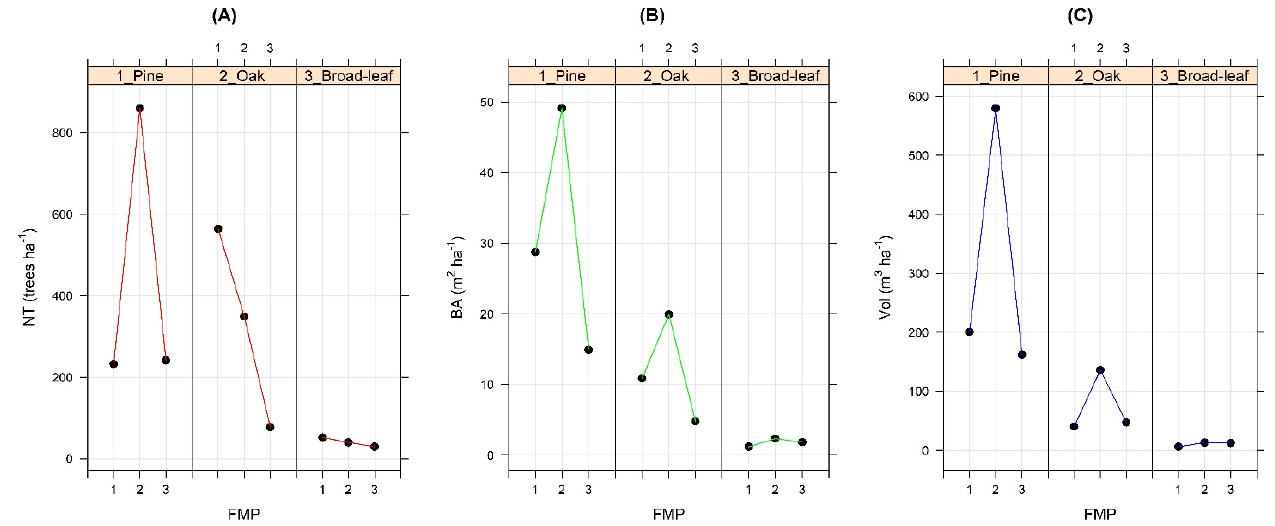
Figure 8. Comparison of number of trees ( NT ) ( A ), basal area ( BA ) ( B ), and volume ( Vol ) ( C ) of the three forest management plans (FMPs) in the L0206 sub-stand.